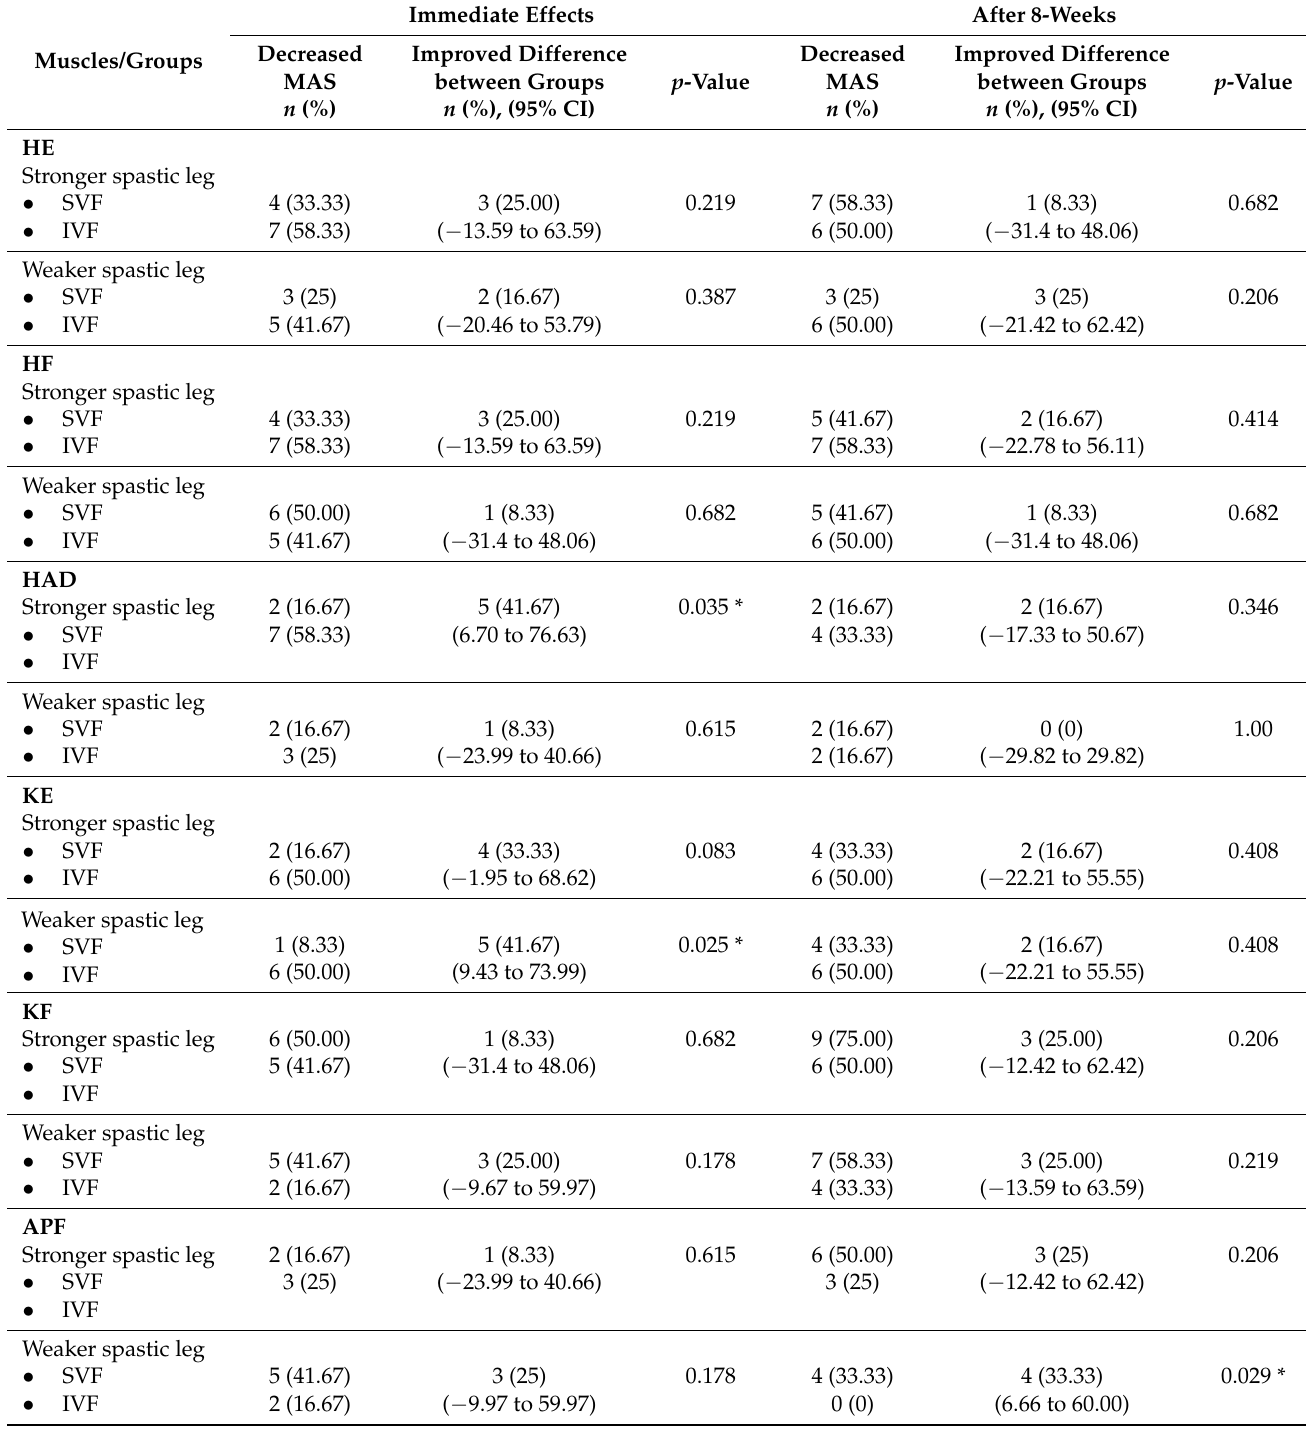
Table 3. The number of decreased MAS subjects (%) and comparisons of an improved difference between groups immediately after and after 8-weeks WBV training ( n =